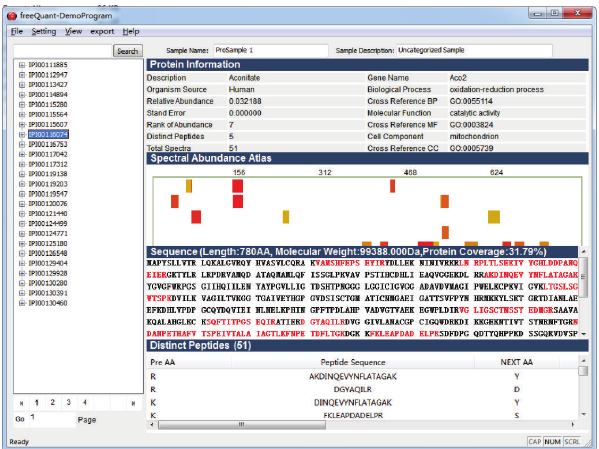
Figure 1: The Interface of freeQuant. Four modules were involved in freeQuant. First, protein information contains basic information of the current protein, such as protein name, relative abundance, and functional annotations. Second, spectral abundance atlas shows the distribution and relative abundance of identified peptides. Third, sequence shows the protein length, molecular weight, and protein coverage. Fourth, distinct peptide shows the correlative information of identified